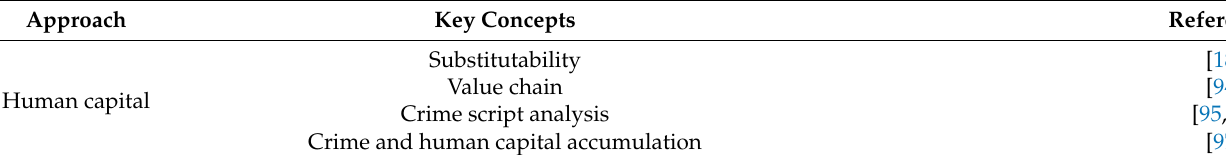
Table 2. Key references about techniques in covert network